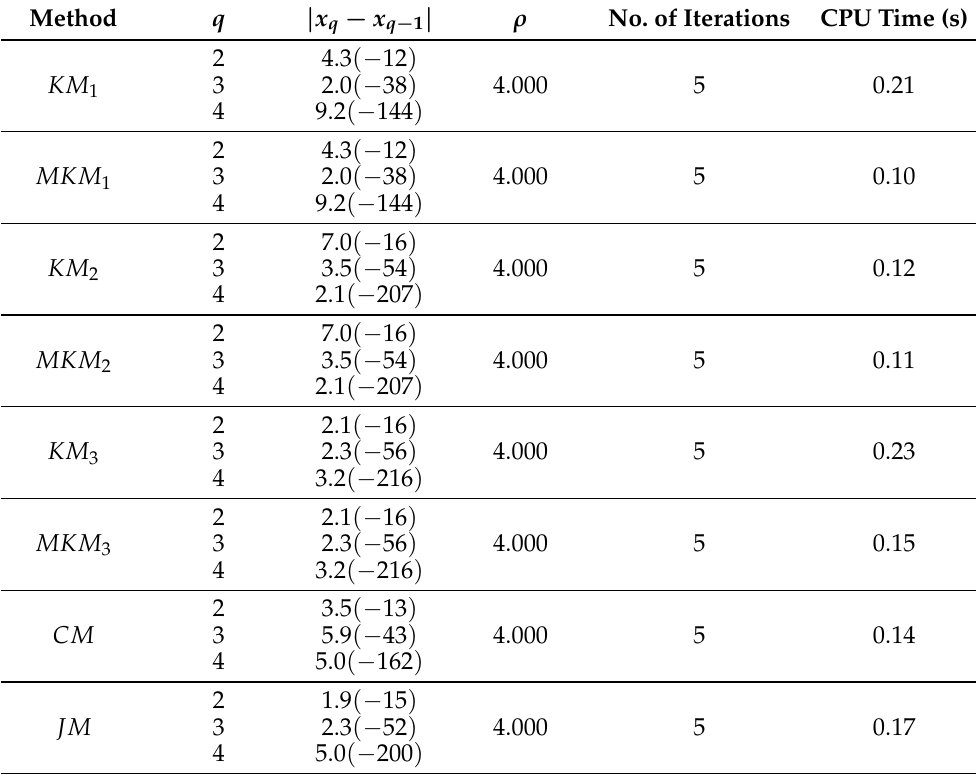
Table 2. Results of Redlich–Kwong equation with initial guess x 0 = 0.11.